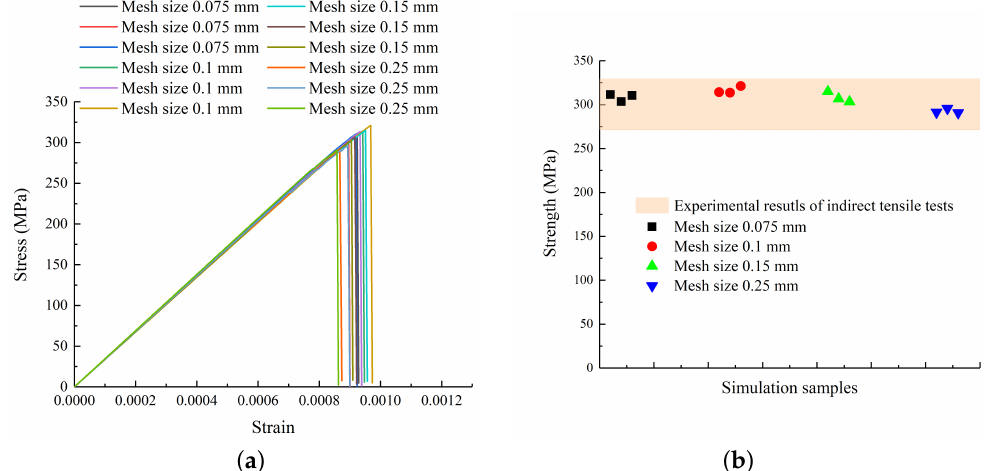
Figure 3. ( a ) Variation of engineering stress-strain response of the CeramTec 98% alumina during the direct tension simulations with four kinds of mesh sizes. ( b ) The shaded region is the tensile strength of the CeramTec 98% obtained by Brazilian disk experiments [29], and the dots are the simulation results with four kinds of mesh